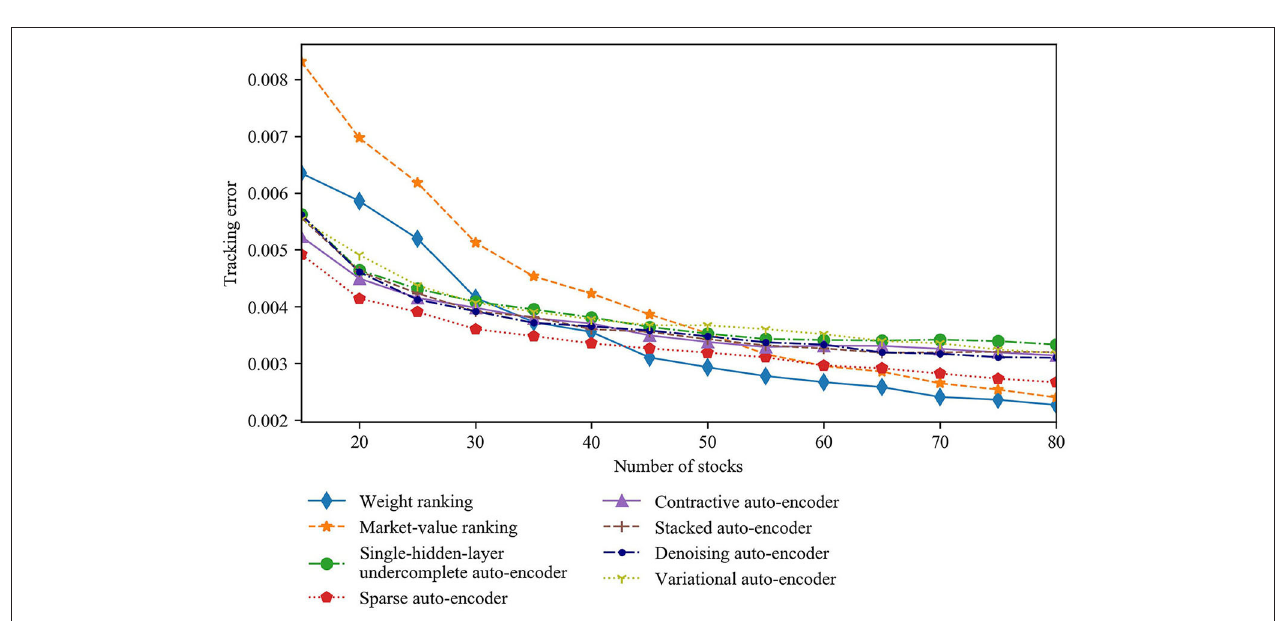
FIGURE 12 | Tracking error curves for all strategies with 3-year training sets.